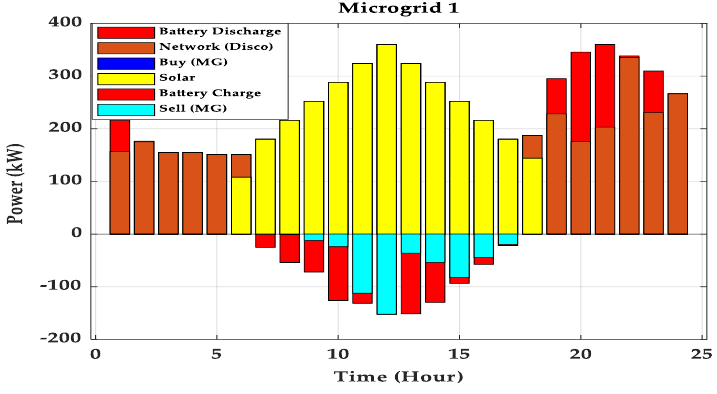
Figure 8. Microgrid 1’s load profile.